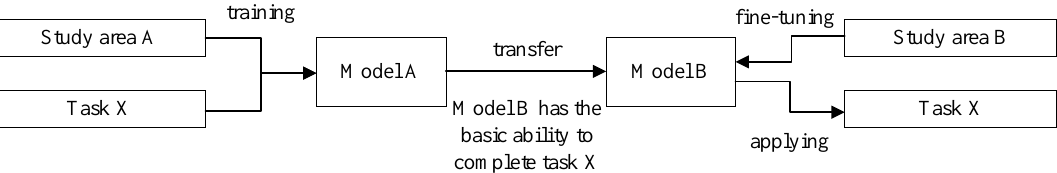
Figure 3. Schematic diagram of transfer learning for 3D reservoir geological modeling.